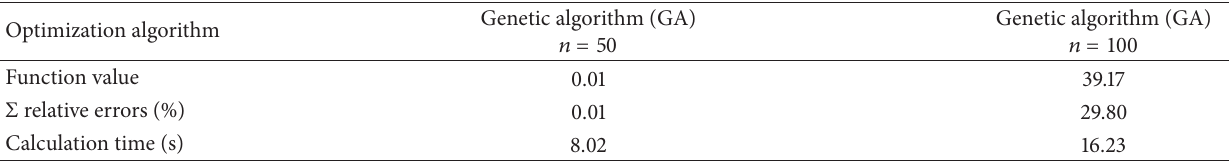
Table 1: Results from optimization for 𝑛 = 50 and 𝑛 = 100 .